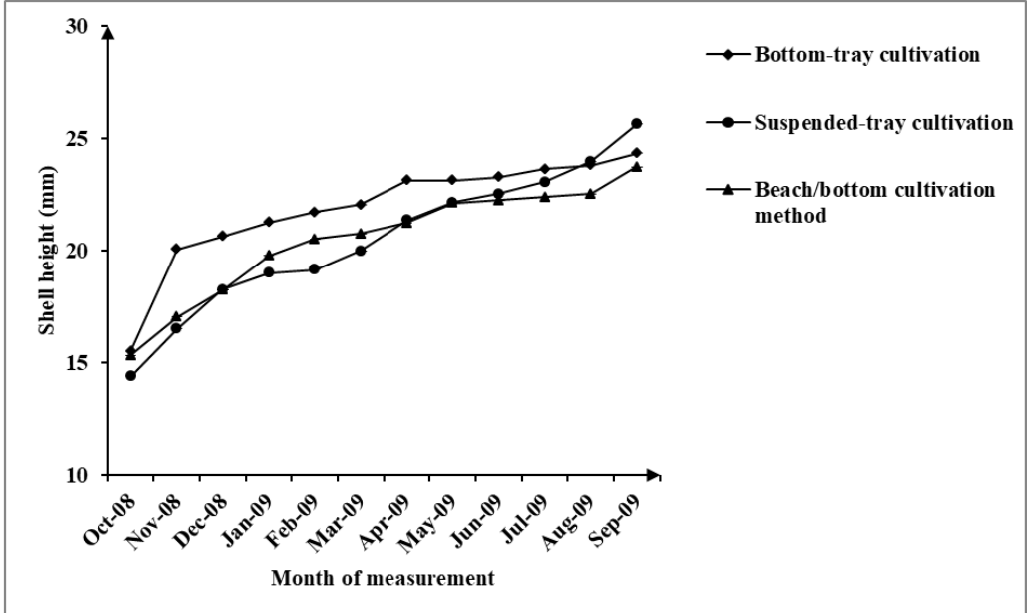
Figure 2. The experiment was conducted from October 2008 to September 2009, this results showed monthly average of shell height (SH) of snout otter clams in bottom-tray cultivation, suspended-tray cultivation, and beach/bottom cultivation methods. The values represented the average of three replicates ± SD ( p > 0.05 ).